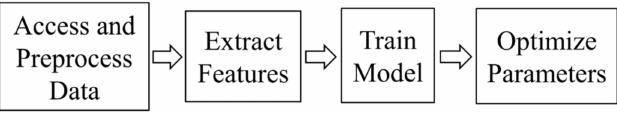
Figure 12. Experimental workflow